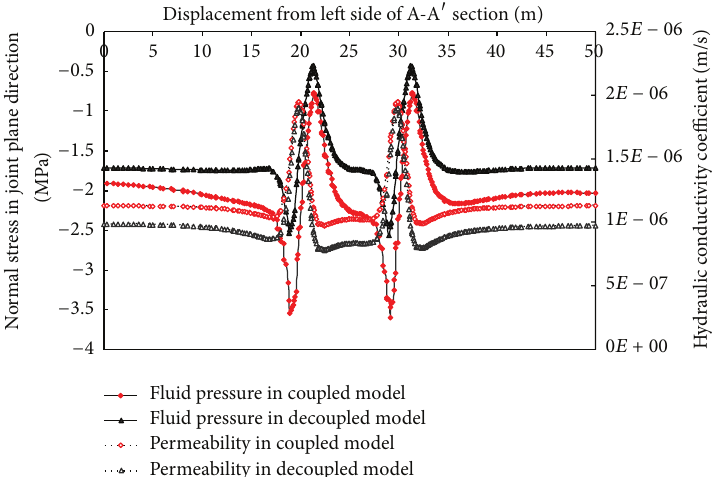
Figure 19: Observed changes of normal stress in joint plane direction and hydraulic conductivity between coupled and decoupled models.